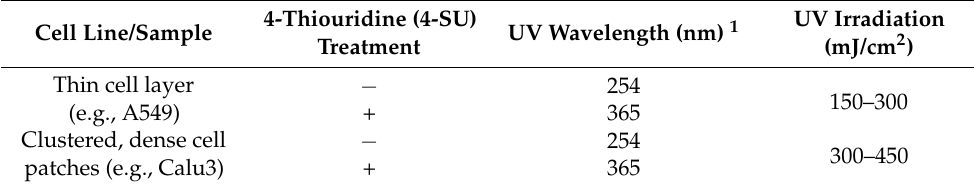
Table 11. PCR Scheme for Preamplification of